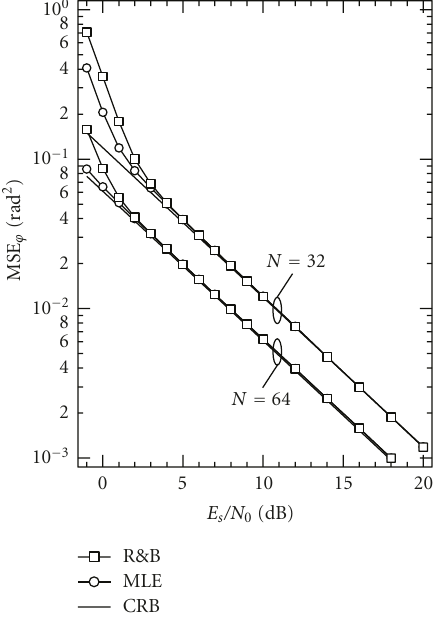
Figure 8: MSE performance of MLE and R&B estimator with N = 32 and N = 64.